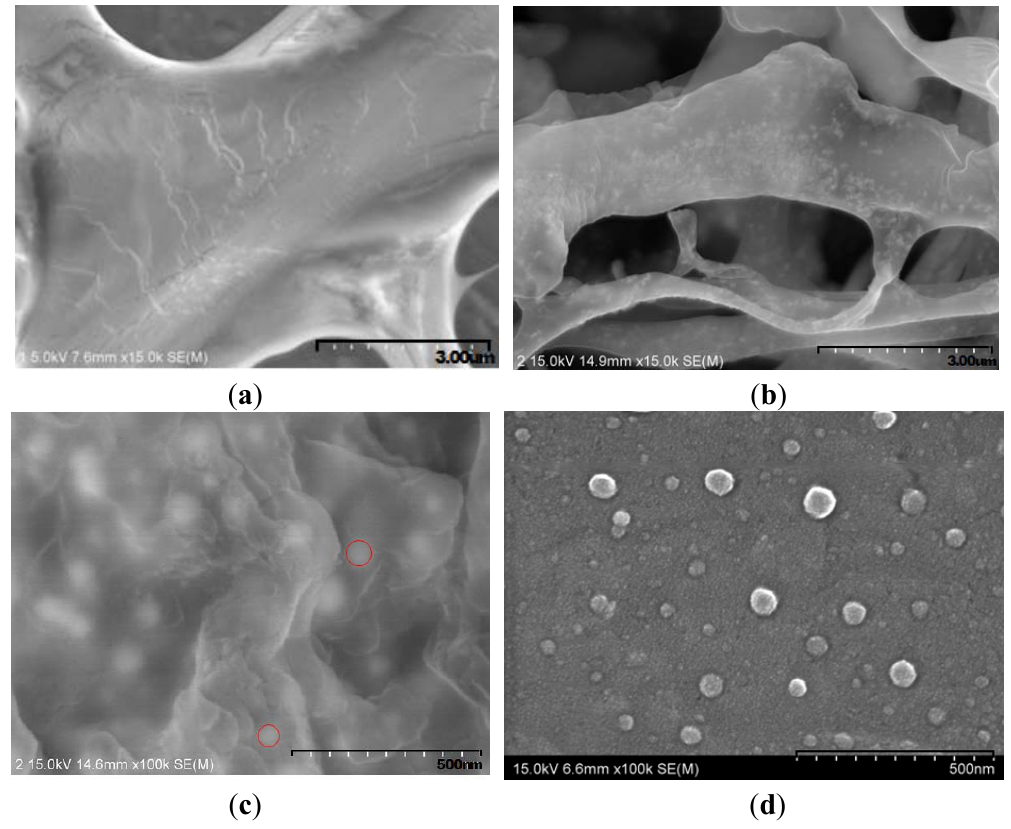
Figure 3. SEM microphotographs of ( a ) DNA (×15.0 k), ( b ) low-magnification of the DNA mediated gold nanoparticle (×15.0 k), and ( c , d ) high-magnification of the DNA mediated gold nanoparticle(×100.0 k). ( b , c ; prepared from solutions, and d; prepared from washed, precipitated and dried